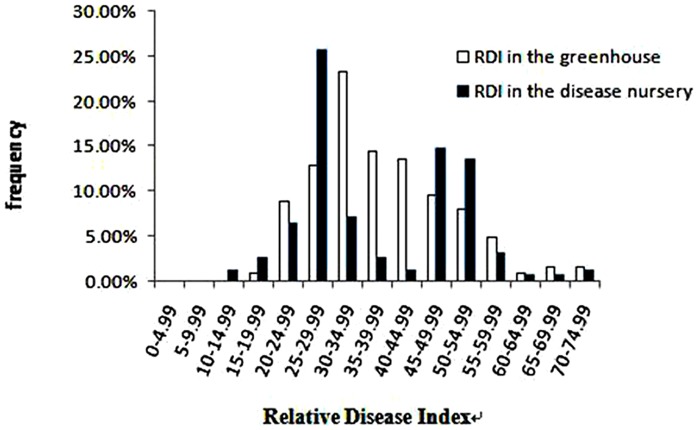
The frequency distribution of Verticillium wilt resistance ratings (indicated by RDI) of 158 accessions in the disease nursery and in the greenhouse environment.